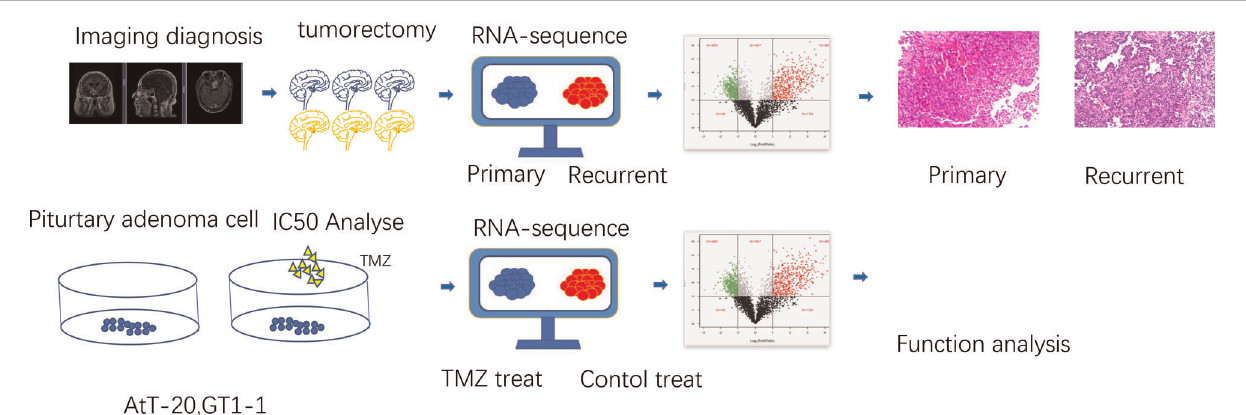
FIGURE 1 | The process design of the experiment. At the tissue level, aggressive pituitary adenomas and primary pituitary adenomas were selected by clinical information and imaging data, and then pituitary adenomas were taken for transcriptional sequencing to screen the differentially expressed genes, and then the expression of differential genes was veri fi ed by immunohistochemistry. At the cellular level, pituitary adenoma cells were treated with TMZ to screen drug- sensitive cell lines, and then transcriptional sequencing was performed to screen differentially expressed genes for analysis.